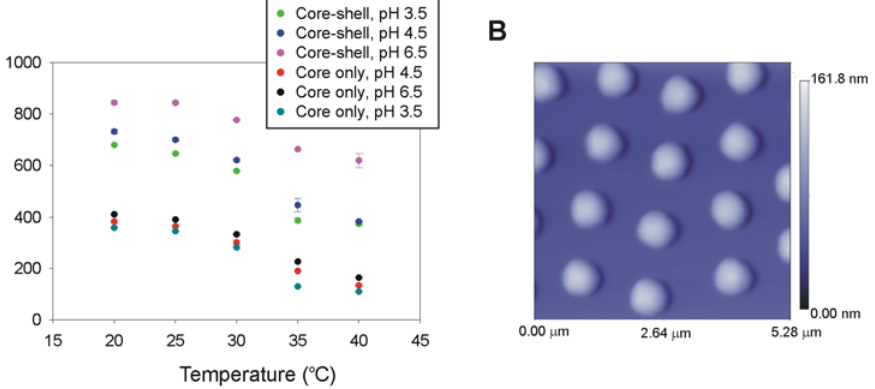
Figure 3. Light scattering and atomic force microscopy characterization of nanoparticles. (A) At room temperature, core is approximately 360 nm in size whereas adding core-shell particles have a diameter of 700 nm at pH 4.5. Core and core shell particles follow a typical temperature dependent behavior. (B) Particle suspension in MilliQ water (pH 5.5, 1 m g/mL) was deposited on freshly cleaved mica under humid atmosphere at room temperature for 15 minutes and dried under nitrogen. Atomic force microscopy (AFM) image of nanoparticles was acquired. Particles have a diameter of approximately 800 nm and exhibit a homogeneous size distribution. The scale bar for particle height shows a maximum height of 168 nm. The AFM picture was acquired under dry status therefore the particles are distorted (flattened) from their spherical shape due to drying on the mica surface.